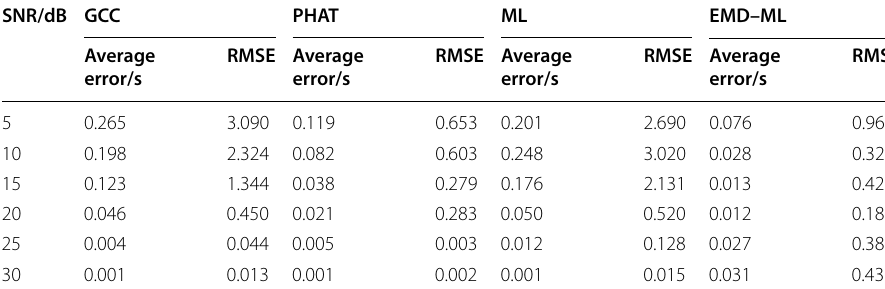
Table 1 Time delay estimation for GCC, PHAT, ML, and EMD–ML